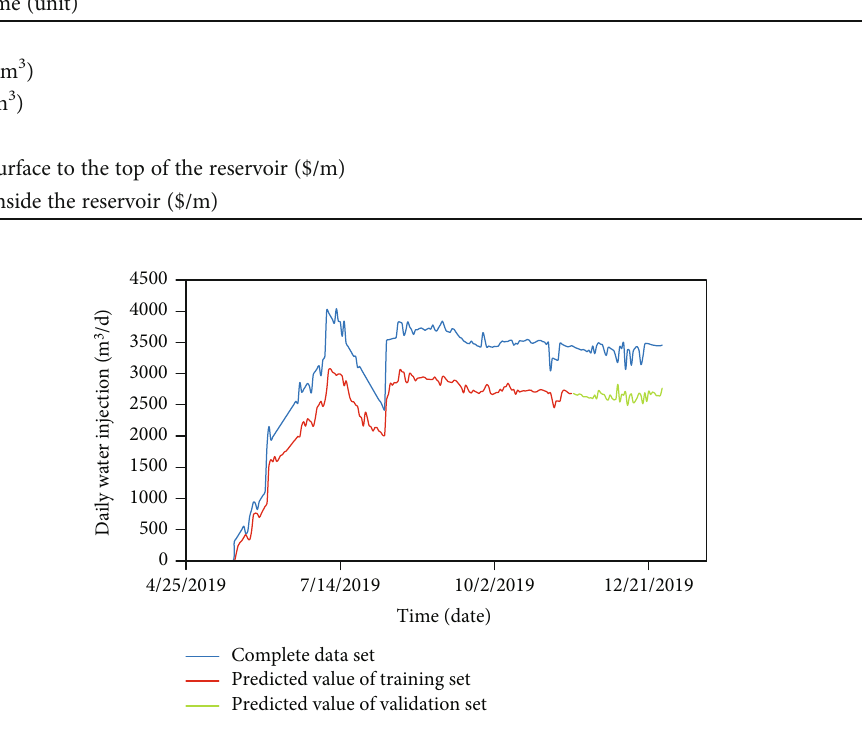
Figure 8: Forecast results of the single-input production dynamic forecasting model.